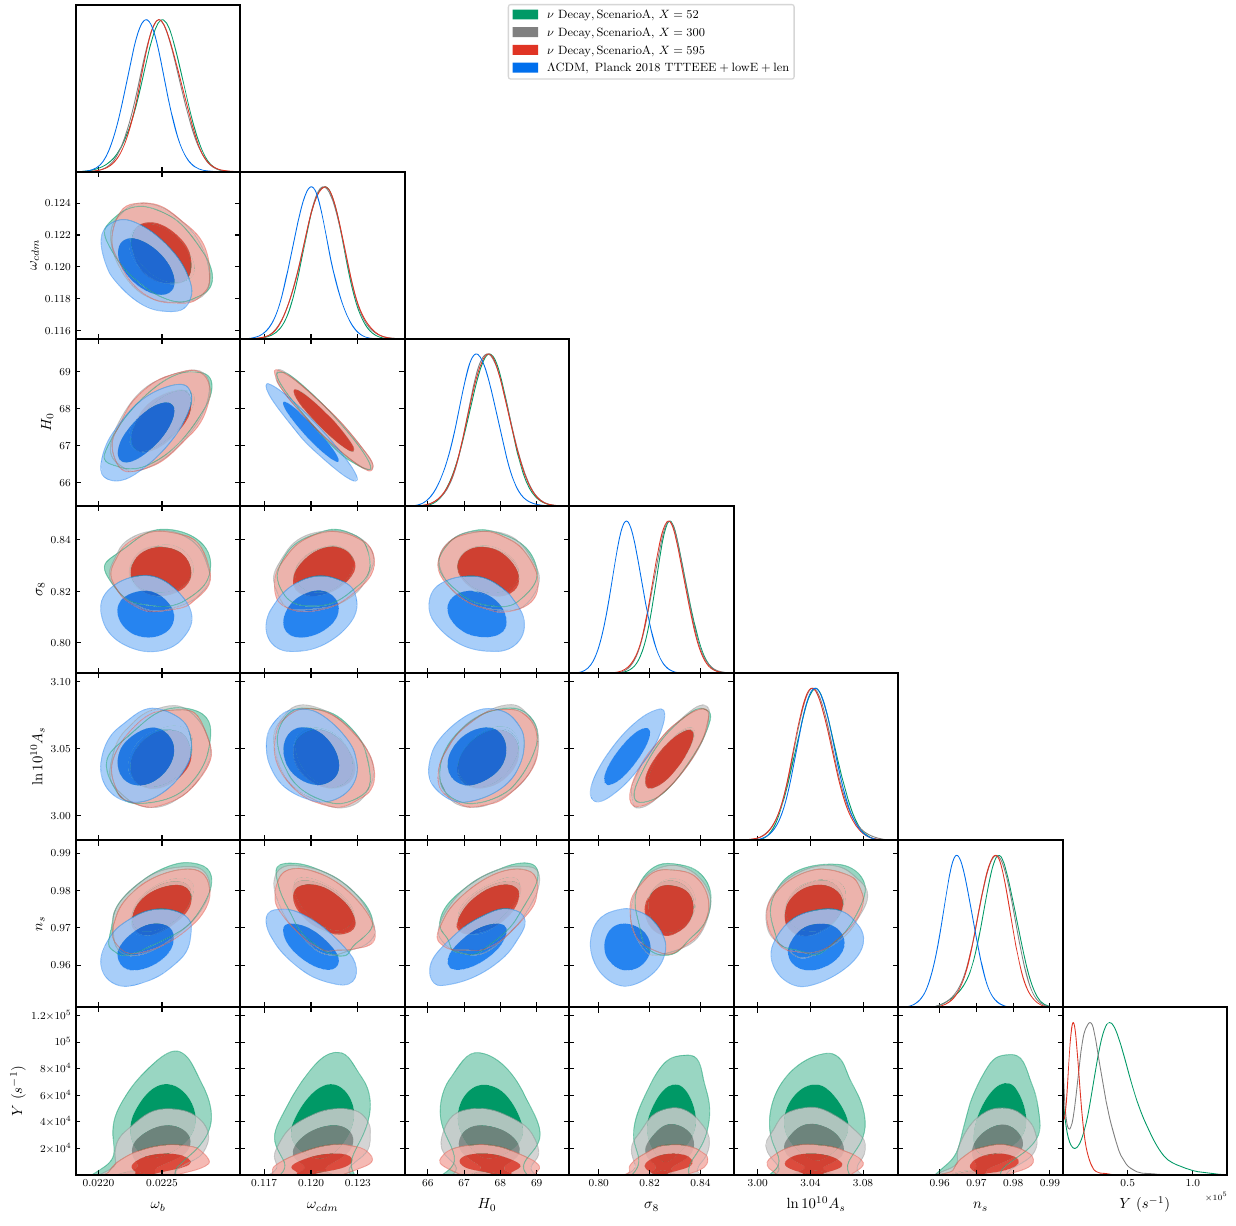
Fig. 5 2D marginalised 68% and 95% contours for the variables of Scenario A, for fixed values of the effective mass parameter X . We show also the corresponding contours from a vanilla (cid:7) CDM